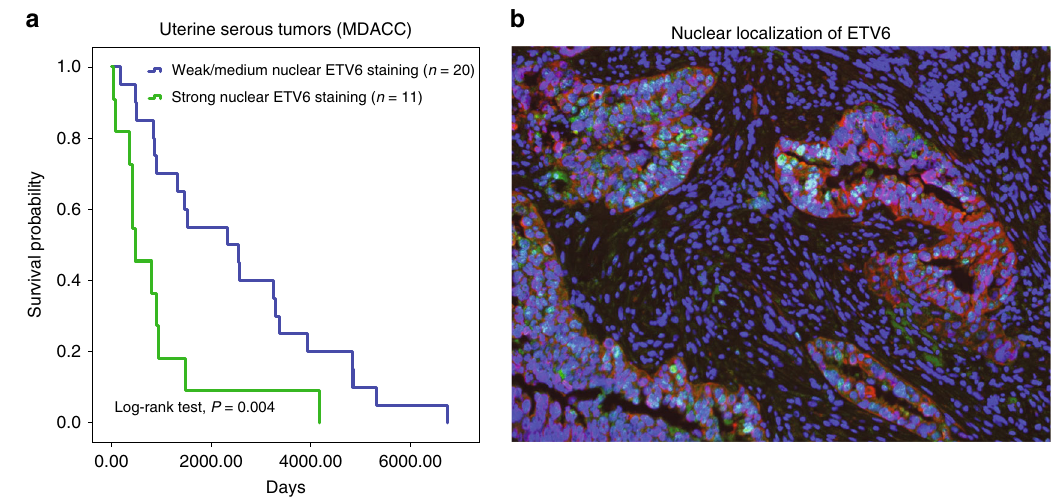
Fig. 5 Clinical validation of ETV6 in uterine serous cancer. a Kaplan – Meier plot for uterine serous patients strati fi ed by ETV6-staining score. Patient samples ( N = 31) were divided into two groups based on intensity of ETV6 and positivity in nuclei or cytoplasm (patients with cytoplasmic, negative or weak/medium [score = 1 or 2] nuclear ETV6 staining, N = 20; and patients with strong [score = 3] nuclear ETV6 staining, N = 11). A signi fi cant difference in survival was observed between the groups ( P = 0.004, log-rank test). The median survival was 2330 days (95% CI: 104 – 4556 days) for the cytoplasmic or weak nuclear group and 214 days (95% CI: 53 – 891) for the strong nuclear group. Source data are provided as a Source Data fi le. b Representative image of immuno fl uorescence staining on a primary uterine serous tumor. Double staining for ETV6 (green) and cytokeratin (red), shows nuclear localization